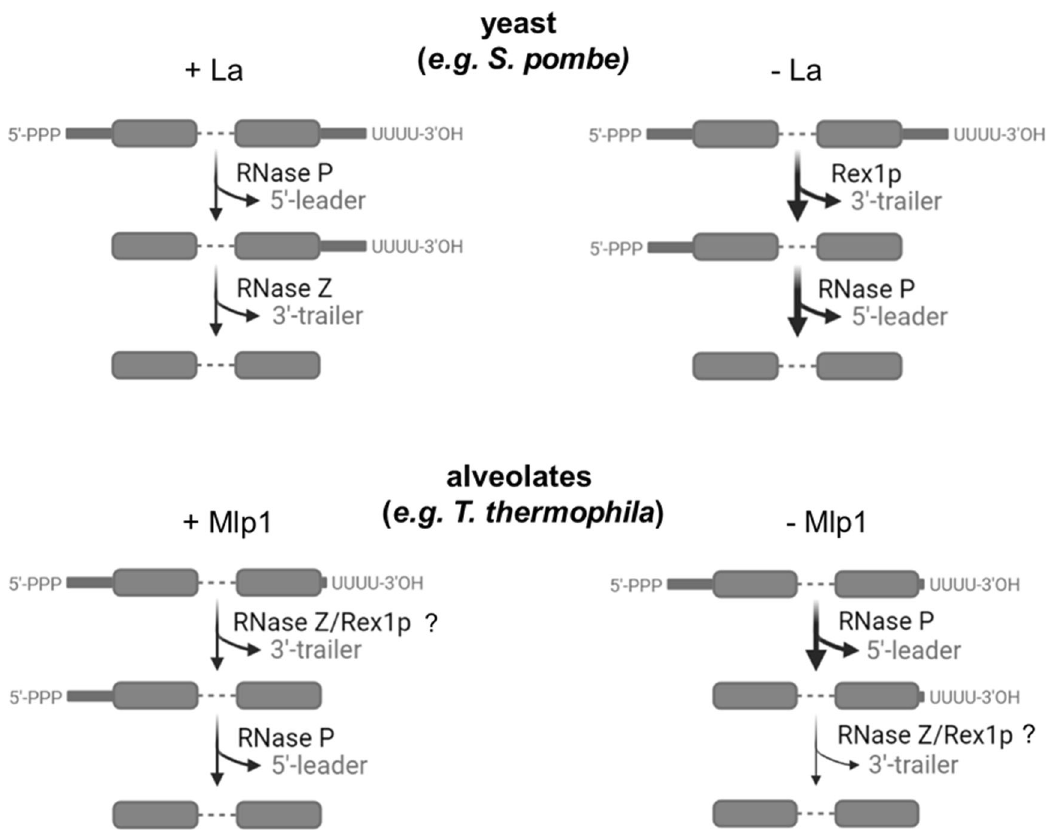
Fig. 7 | Model for pre-tRNA processing in T. thermophila . During La-dependent processing(top,left)inpreviouslystudiedeukaryotessuchasyeast,theLaprotein is the fi rst protein to associate with pre-tRNAs on the 3 ’ -stretch of uridylates gen- erated by RNA polymerase III transcription termination. Binding of La provides protectionfromdegradationby3 ’ -exonucleases,assistswithtRNAfoldingthrough RNAchaperone activityand stabilizesthe nascent pre-tRNA.Thenextstep in tRNA processing is endonucleolytic removal of the 5 ’ -leader by RNase P, followed by an endonucleolytic cut by RNase Z resulting in removal of the 3-trailer sequence and the La protein bound to the uridylate stretch. In contrast, during La-independent